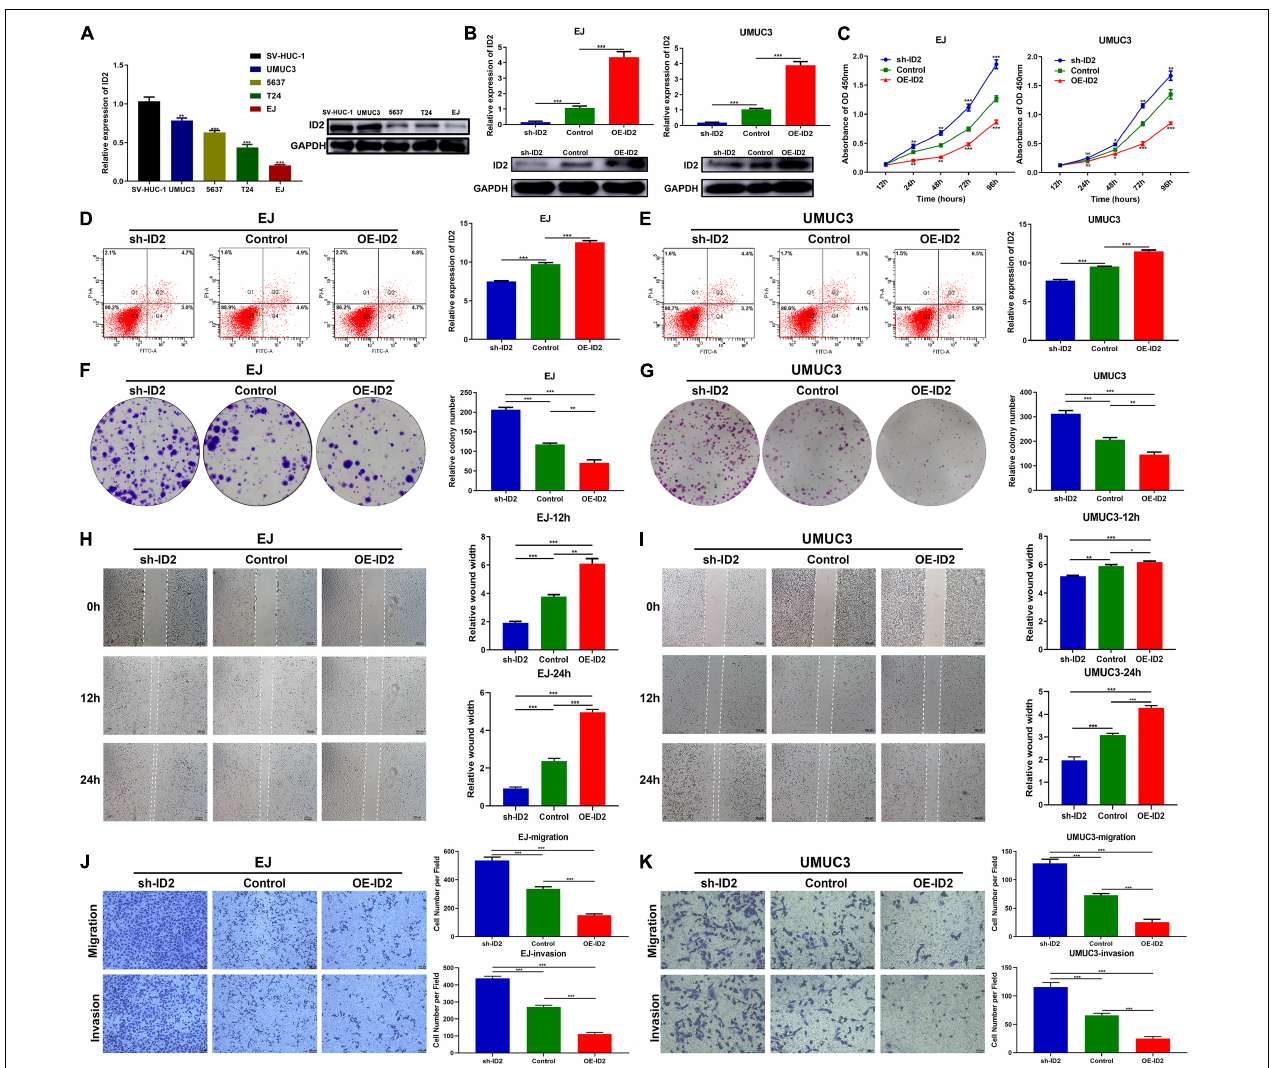
FIGURE 3 | ID2 inhibits proliferation, migration and invasion of BCa cells in vitro . (A) Relative expression of ID2 in SV-HUC-1 cell and BCa cell lines. (B) Expression of ID2 was confirmed by qRT-PCR in BCa cell lines EJ and UMUC3 transfected with sh-ID2, Control or OE-ID2. (C) CCK8 assay of cell proliferation capacity of EJ and UMUC3 cells after transfection with sh-ID2, Control, or OE-ID2. (D,E) Cell apoptosis assay were performed in EJ (D) and UMUC3 (E) cells after transfection with sh-ID2, Control or OE-ID2. (F,G) Colony formation assays were performed in EJ (F) and UMUC3 (G) cells after transfection with sh-ID2, Control, or OE-ID2. (H,I) Wound healing assays were performed in EJ (H) and UMUC3 (I) cells after transfection with sh-ID2, Control, or OE-ID2. (J,K) Transwell assays were performed in EJ (J) and UMUC3 (K) cells after transfection with sh-ID2, Control, or OE-ID2 (* p < 0.05, ** p < 0.01, *** p < 0.001).